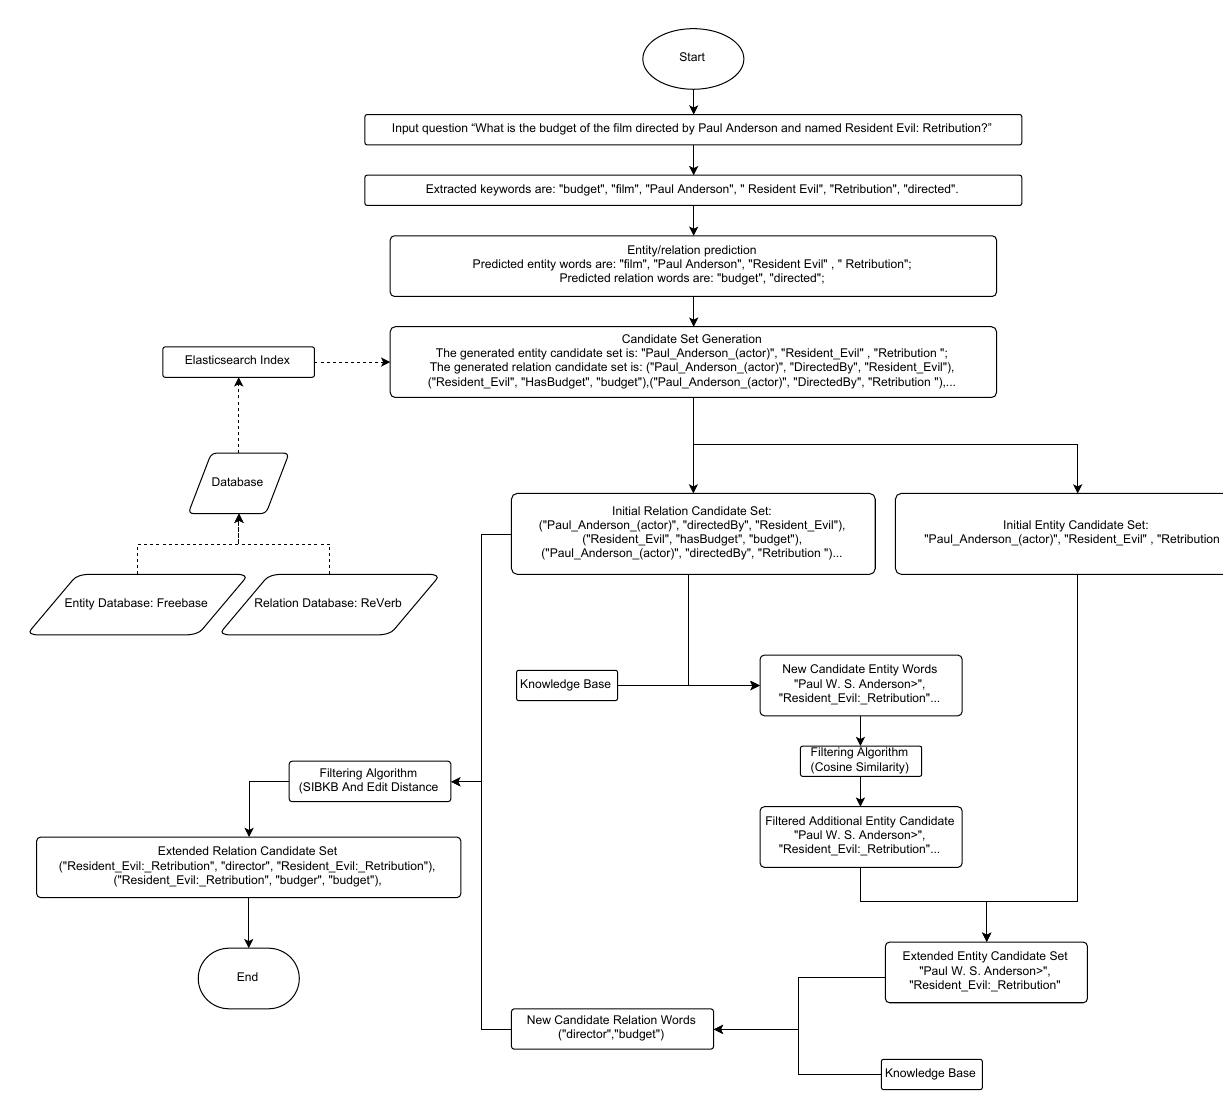
Figure 3. The data-processing procedure of question (1) in the methodology of this